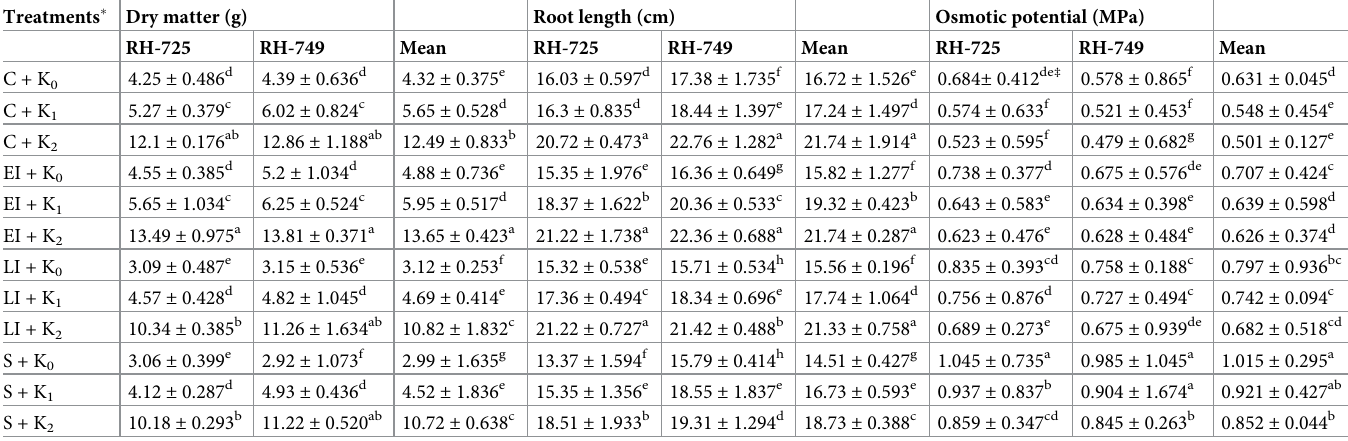
Table 2. Effects of irrigation regime and potassium fertilizer on morphological traits of Brassica juncea cultivars. Treatments � Dry matter (g)